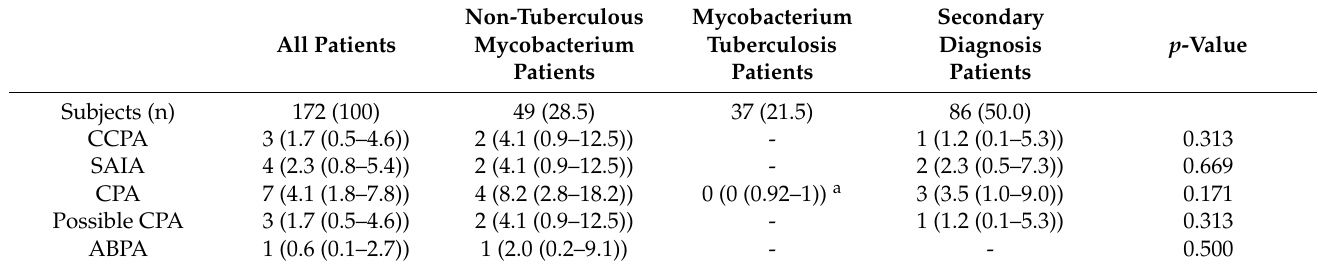
Table 2. Incidence of chronic pulmonary aspergillosis.